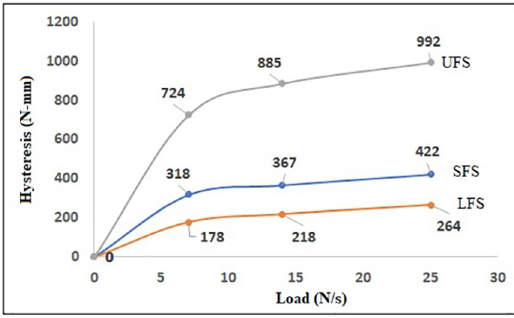
Figure 4. Performance of reinforced and unreinforced springs